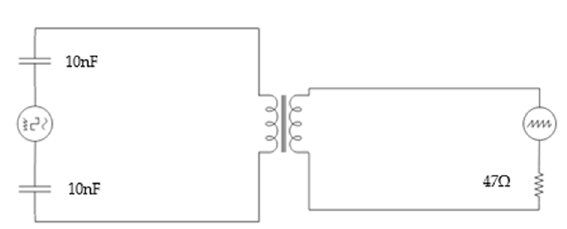
Figure 4. Diagram of the electronic circuit used in the experiment.